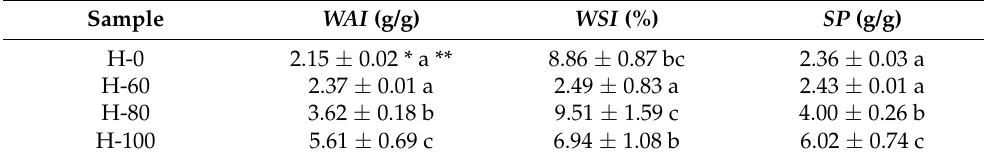
Table 3. Hydration properties (water absorption index ( WAI ), water solubility index ( WSI ), and swelling properties ( SP )) of native adlay flour (H-0) and pre-gelatinized adlay flours prepared